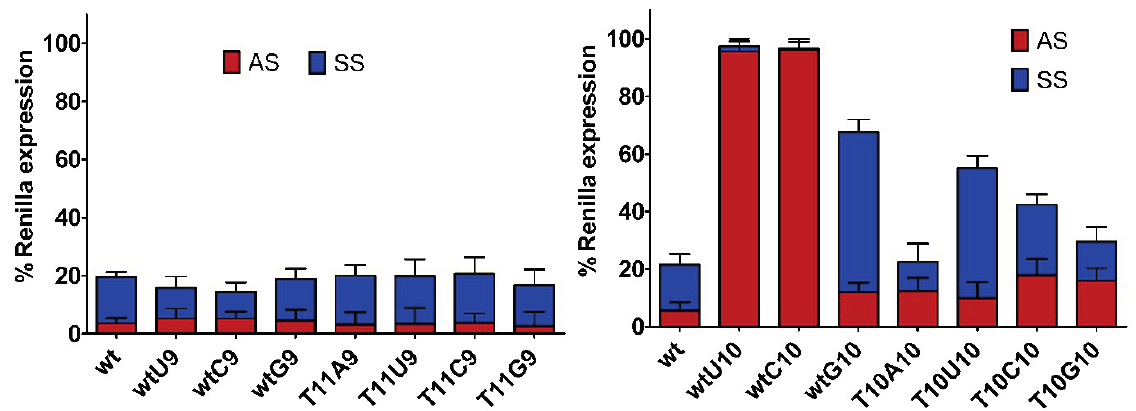
Figure 4. Silencing activities of antisense strand ( AS ) and sense strand ( SS ) of mismatched siRNAs at position 9 (left panel) and position 10 (right panel) bearing either natural uridine ( wt ) or L -threoninol-thymine ( T L ). To assess the on-target and off-target effects, 1 nM of the indicated siRNAs were co-transfected with psiCHECK2 reporters ( AS or SS , SSU9 , SSC9 , SSG9 , SSU10 , SSC10 and SSG10 , respectively) in HeLa cells. Mock transfection was set as 100%. n = 3 ±